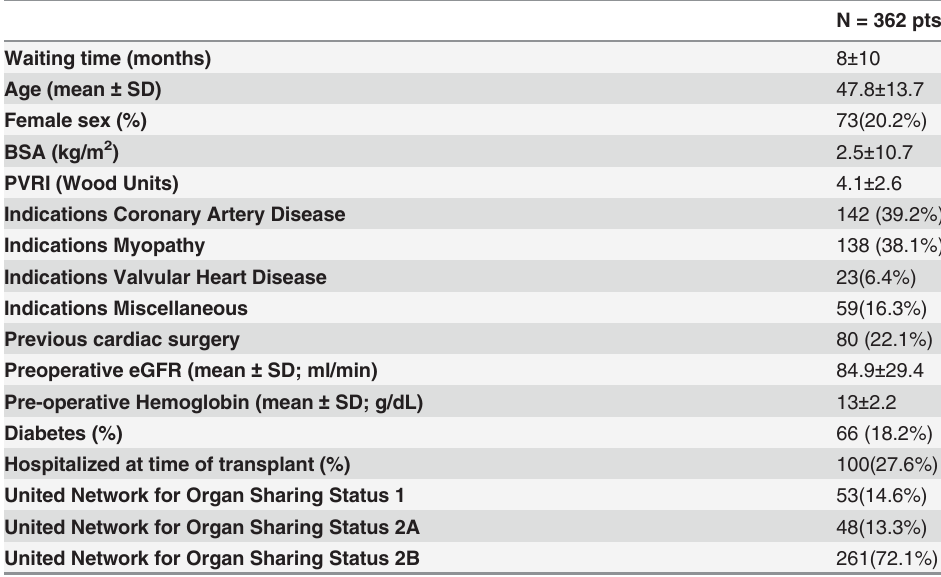
Table 1. Recipients